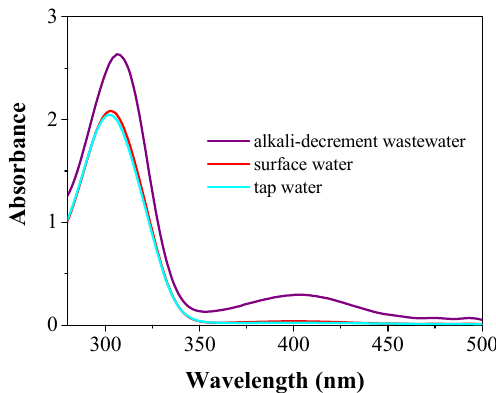
Figure 5. UV-Vis absorption spectra of three 4-NP spiked real water samples after a single passing through an Au/N-rGO filter. Experimental conditions: 0.2% Au/C ratio, 1.0 mL/min flow rate, 1.0 mM 4-NP, and 250-fold excess NaBH 4 .